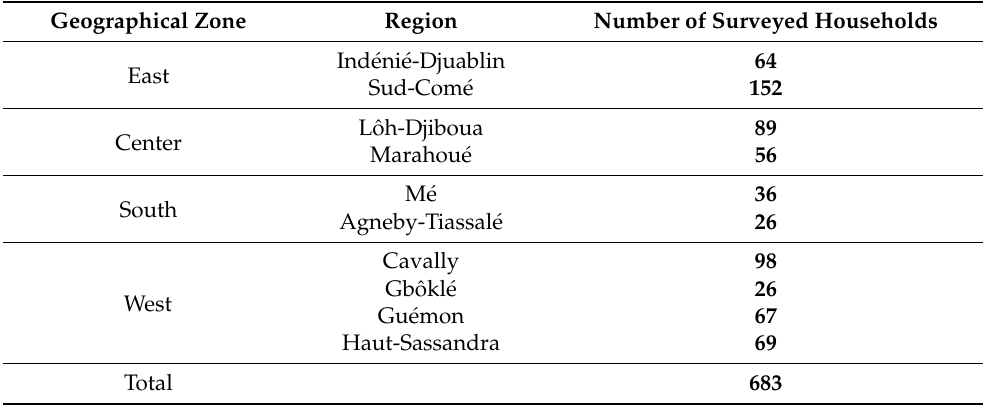
Table 1. Number of surveyed households and localization of sampling sites to determine the drivers of tree introduction to cocoa farms in C ô te